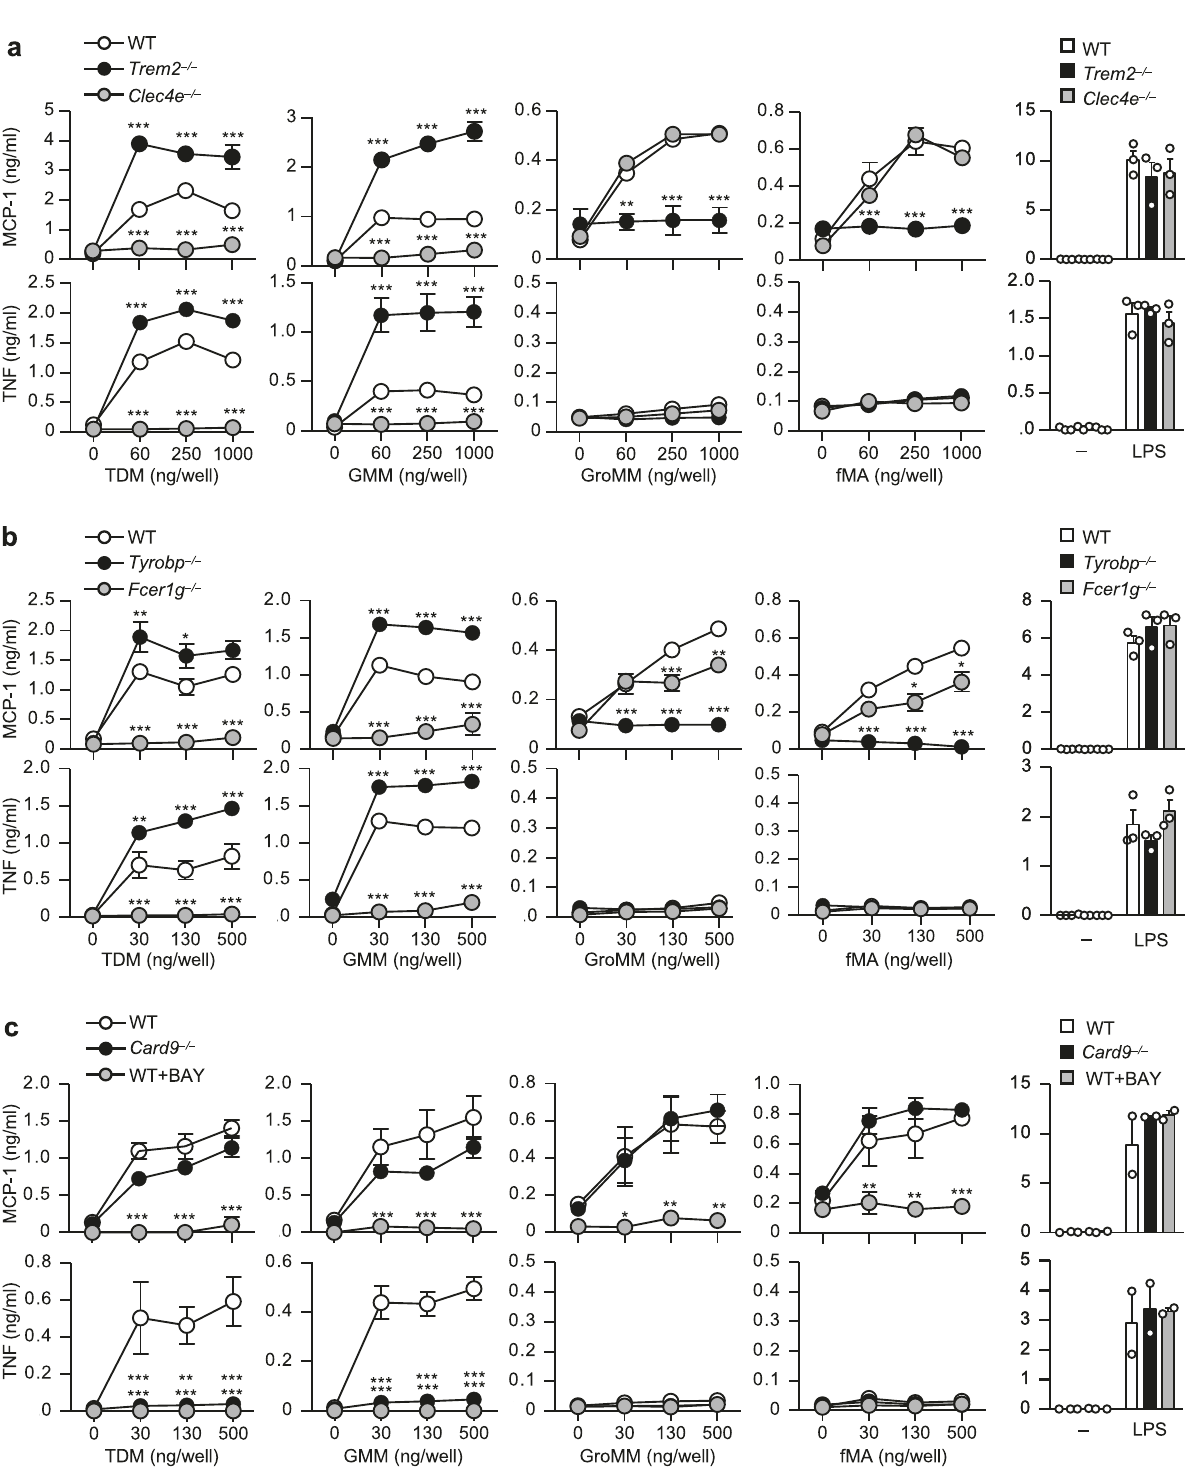
Fig. 4 Distinct lipid recognition and macrophage activation through Mincle and TREM2. a – c Peritoneal macrophages from wild-type (WT), Trem2 − / − , or Clec4e − / − mice ( a ), WT, Tyrobp − / − , or Fcer1g − / − mice ( b ), or WT or Card9 − / − mice ( c ) were stimulated with the indicated amounts of TDM, GMM, GroMM, or fMA coated on the plates or with LPS (100 ng/ml) for 24 h. WT cells were stimulated in the presence or absence of the Syk inhibitor BAY- 613606 (BAY) ( c ). MCP-1 and TNF production in the culture supernatant was measured by ELISA. Data are presented as the mean ± SEM of triplicate assays and are representative of three independent experiments. The statistical signi fi cance was calculated by two-way ANOVA followed by Bonferroni ’ s test. * p < 0.05, ** p < 0.01, *** p < 0.001. Source data are provided as a Source data fi le.